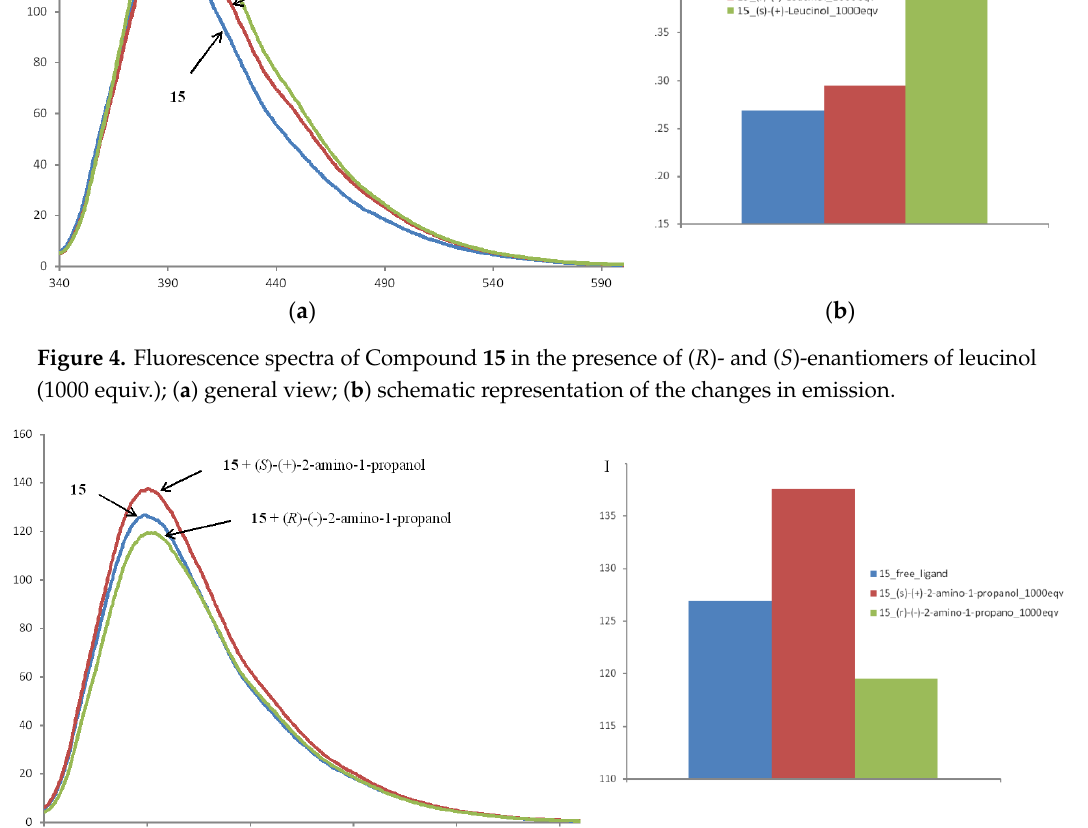
Figure 6. Fluorescence spectra of compound 16 in the presence of ( R )- and ( S )-enantiomers of leucinol (1000 equiv.). The ligand 16 possesses two 6-aminoquinoline moieties, with the emission maximum at 505 nm. The addition of ( S )- and ( R )-leucinol led to emission quenching, but in the case of the ( S )-isomer, the second maximum of lower intensity emerged at 415 nm (Figure 6); thus, it can be used for recognition between these two enantiomers. A similar spectral behavior of compound 16 was noted when adding ( S )-2-amino-1-propanol (Figure 7); however, in this case, the effect was not so pronounced as only the shoulder at 400–420 nm was noted. The nature of these additional emission maxima in the spectra is vague. ( S )-enantiomers of tert -leucinol and 2-amino-1-propanol did not cause this effect with the other ligands tested, and one may assume that this effect could arise from a specific interaction of two fluorophore moieties present in the compound 16, i.e., BINAM and quinoline fragments. The coordination with these aminoalcohols could promote the rapprochement of the two fluorophores to produce a new emission band. However, this phenomenon needs to be studied specially. The second plausible explanation is the coordination of the amino alcohol with the nitrogen atom of the quinoline moiety causing the hypsochromic shift. Another coordination mode that does not involve the